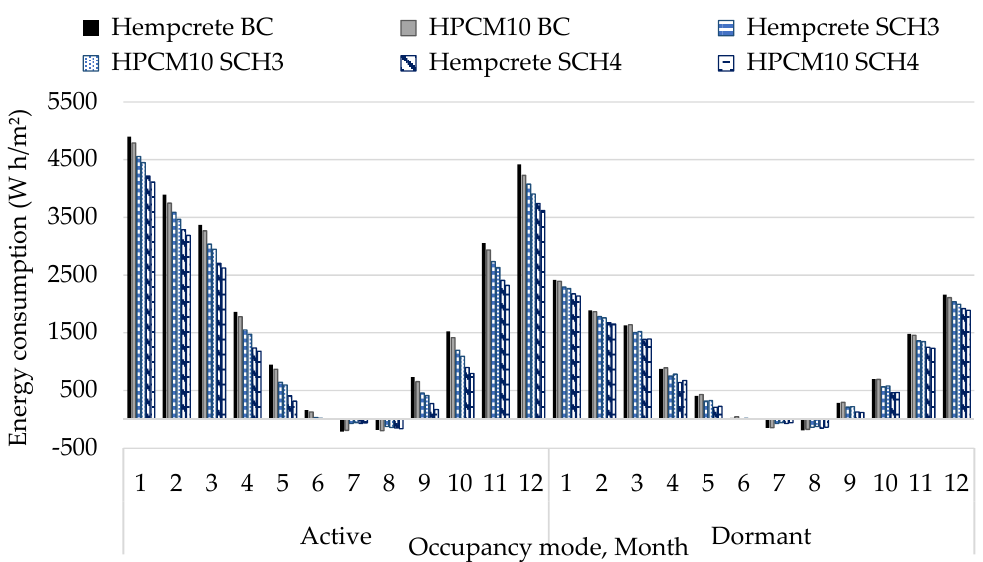
Figure 12. Average monthly heating and cooling energy consumption under BC, SCH3, and SCH4.